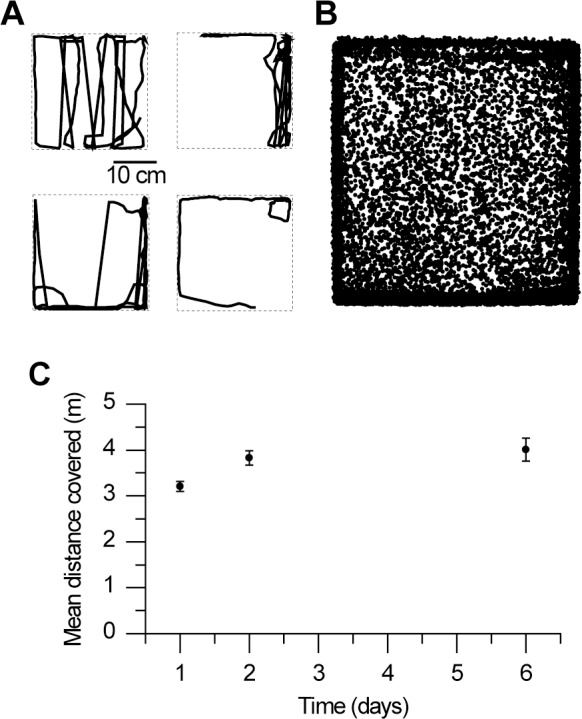
Video tracking of bees using a vertical arena.
A, Examples of paths followed during 3 minutes by four individual young bees (day 1 after emergence). B, Superimposed paths followed by eighty individual bees. Overall, arena sides were more frequently visited. C, Locomotor ability measured at day 1, 2 and 6 after emergence (bees kept in an incubator). Mean distance (± S.E.M) covered by bees slightly increased from 3.2 to 3.8 meters between day 1 and 2 (p<0.01, n = 138 and 63 respectively) and did not significantly further increase as shown at 6 days after emergence (n = 38).